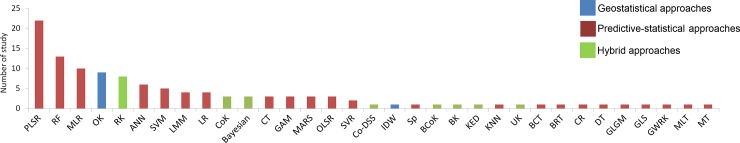
Frequency of use of the different spatialization techniques across the reviewed papers.–Bars represent the number of studies that used the following techniques to predict soil properties: PLSR (Partial Least Squares Regression), RF (Random Forest), MLR (Multi Linear regression), OK (Ordinary Kriging), RK (Regression Kriging), ANN (Artificial Neural Network), SVM (Support Vector Machine), LMM (Linear Mixed Model), LR (Linear Regression), CoK (Co-kriging), Bayesian (Bayesian), CT (Classification trees), GAM (Generalised Additive Model), MARS (Multivariate Adaptive Regression Splines), OLSR (Ordinary Least squares Regression), SVR (Support Vector Regression), Co-DSS (Direct Sequential Co-Simulation), IDW (Inverse Distance Weighted), SK (Simple kriging), Sp (Splines), BCok (Block-Co-Kiging), BK (Block Kriging), KED (Kriging with external drift), KNN (K-nearest neighborhood), UK (Universal kriging), BCT (Boosted classification tree), BRT (Boosted Regression Trees), CR (Cubist regression), DT (Decision tree), GLGM (Generalised linear geostatistical model), GLS (Generalised least squares), GWRK (Generalised Weighted Regression Kriging), MLT (Machine learning tree), and MT (Model Tree).